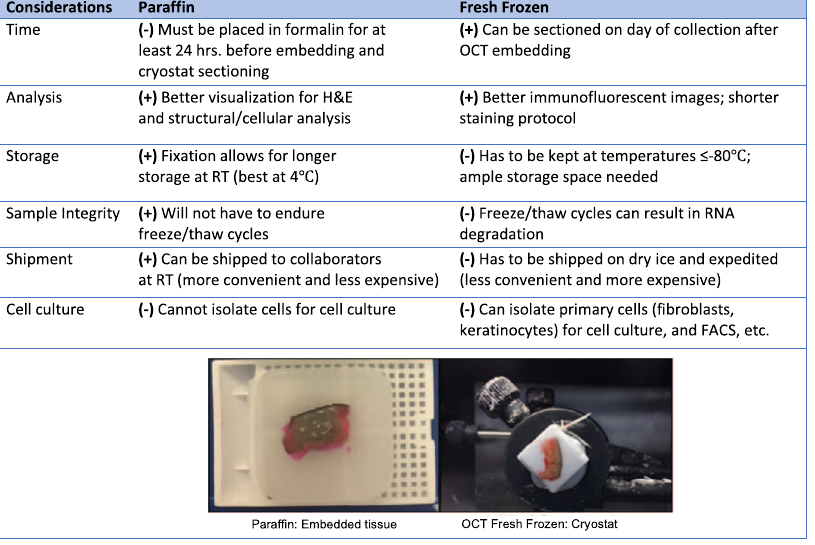
Figure 6. Comparative analysis of paraffin and fresh frozen tissue with images. Positive and/or negative aspects for each consideration when processing tissue as paraffin or fresh frozen are listed. Images of possible analysis techniques are shown. ( + ) denotes positive aspect; ( − ) denotes negative